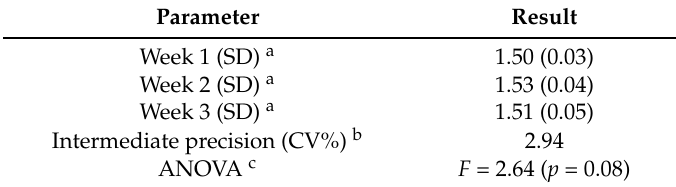
Table 2. Results obtained for the precision set, coefficient of variation and ANOVA probability.